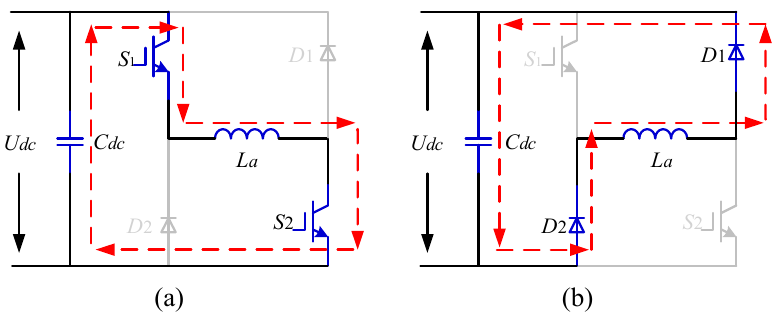
Figure 1. Schematic of switched reluctance motor (SRM).